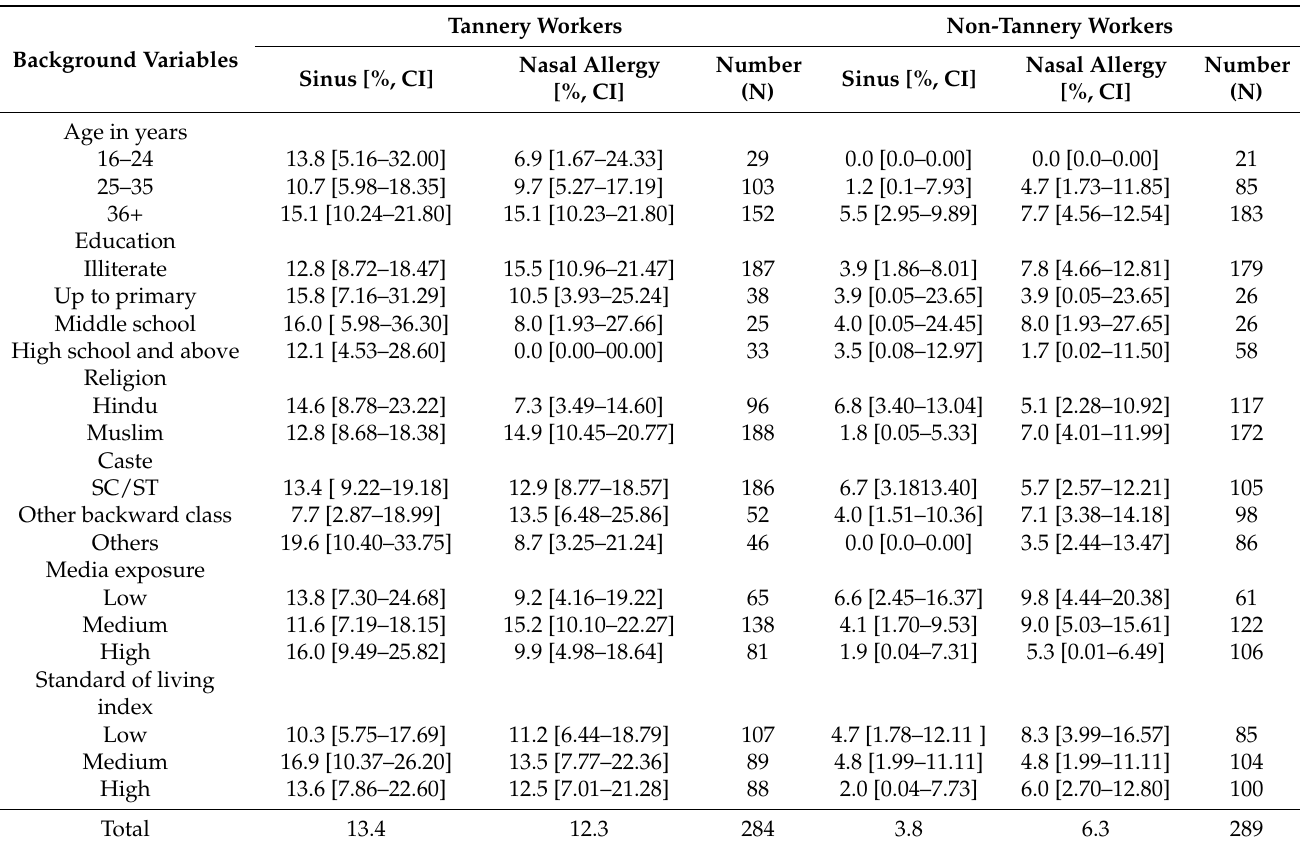
Table 3. Prevalence of sinus and nasal allergies reported by the tannery and non-tannery workers in Kanpur, India, 2015.